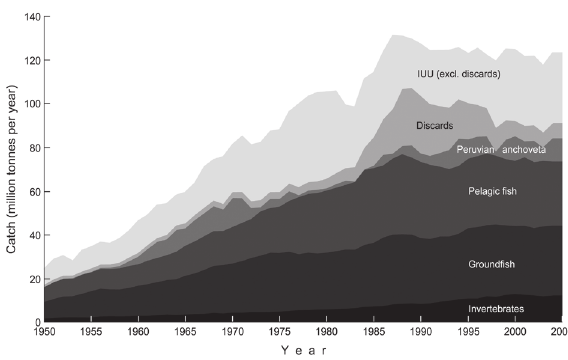
Fig . 1. – Global marine fisheries catches, 1950-2004. This graph differs from the ‘official’ (FaO) version of catch trend in that it accounts for ( i ) catch over-reporting by China (Watson and Pauly, 2001); ( ii ) discarded by-catch (Zeller and Pauly, 2005), and ( iii ) catch of iuu fisheries, based on Figure 1 in Pauly et al. (2002). note that the discards and the other catch of iuu fisheries are very tentative, but their values are certain to be